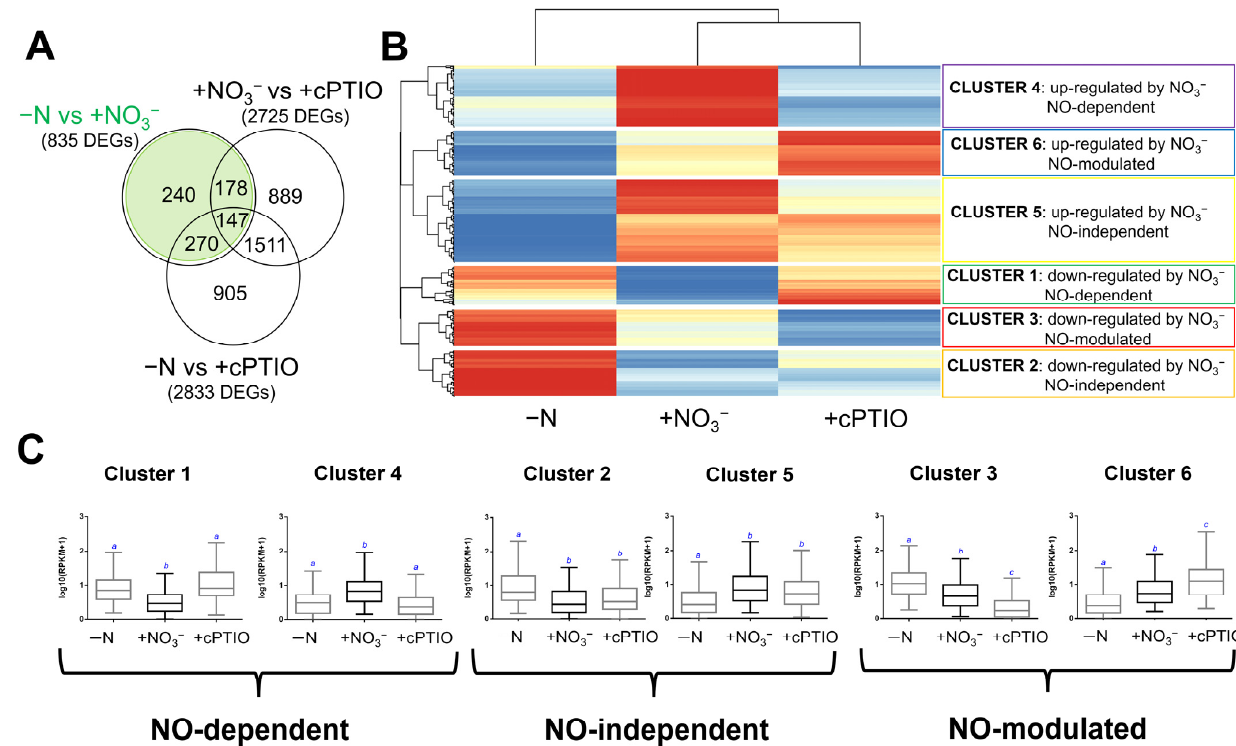
Figure 1. Venn and clustering analysis of genes differentially expressed in +NO 3 − and +NO 3 − + cPTIO treatments with respect to the control ( − N) in maize root tissues. ( A ) Venn diagram showing the numerical comparison of all significant (log2 FC > |1|; FDR ≤ 0.05) differential expressed genes (DEGs) following − N, +NO 3 − , and +NO 3 − + cPTIO treatments. ( B ) Clustered heat map of expression changes in pairwise comparison between − N (control), +NO 3 − and + cPTIO treated roots, for the 835 shared DEGs. DEGs normalized z-scaled expression values are reported in a blue to red color scale (blue: lower RPKM values, red: higher RPKM values). ( C ) Boxplot of normalized expression values presented as log10 transformed RPKM for the genes included in each cluster; blue letters indicate Mann–Whitney statistics test with p < 0.01. The analysis reveals 6 clusters that could be described by the expression behaviors in response to NO 3 − provision and NO-(un)responsiveness: Cluster 1 (NO-dependent and down-regulated by NO 3 − ), cluster 2 (NO-independent and down- regulated by NO 3 − ), cluster 3 (NO-modulated and down-regulated by NO 3 − ), cluster 4 (NO-dependent and up-regulated by NO 3 − ), cluster 5 (NO-independent and up-regulated by NO 3 − ), and cluster 6 (NO-modulated and up-regulated by NO 3 − ). RPKM: Reads Per Kb per Million; FC: Fold change.